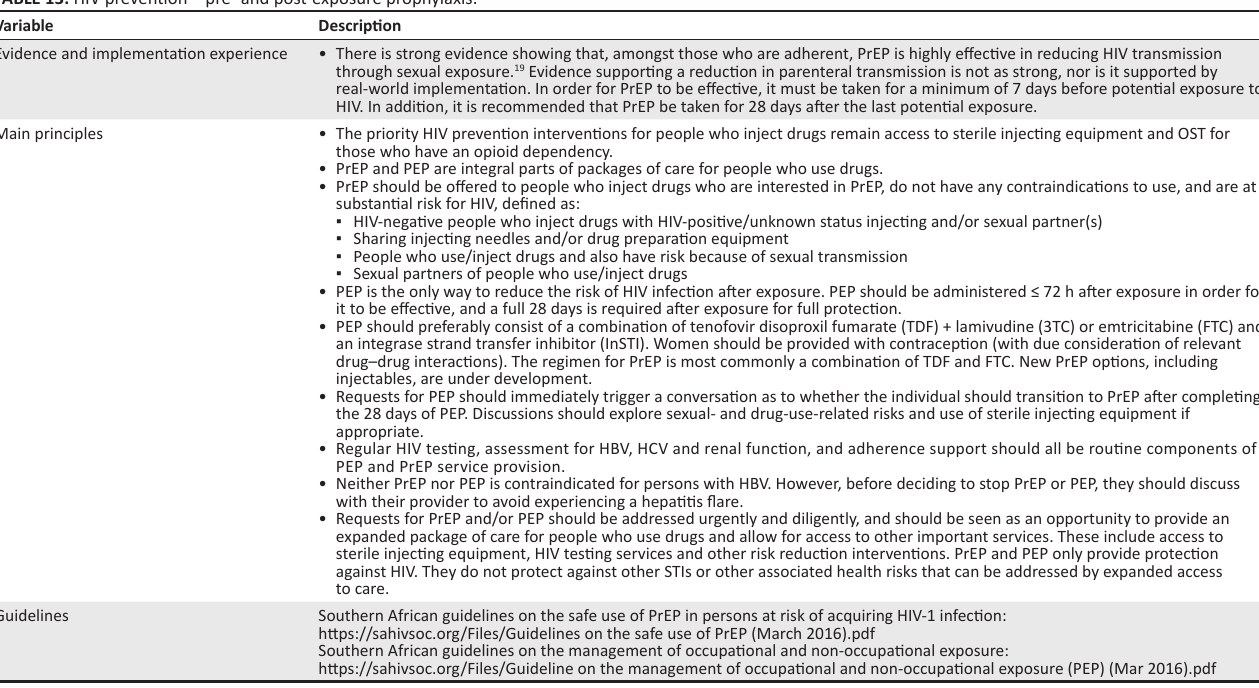
TABLE 13: HIV prevention – pre- and post-exposure prophylaxis. 19 Variable